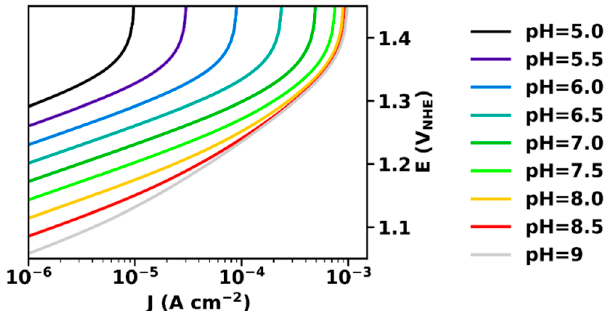
Figure 2. Current–voltage relation (Tafel-plots) at various pH, calculated according to Equation (20). The parameters used for simulation were: α ET = 1, k D = 10 mA cm mol − 1 , B 0 = 0.1 M, pK aB = 7, J e0 = 10 − 12 A cm − 2 .